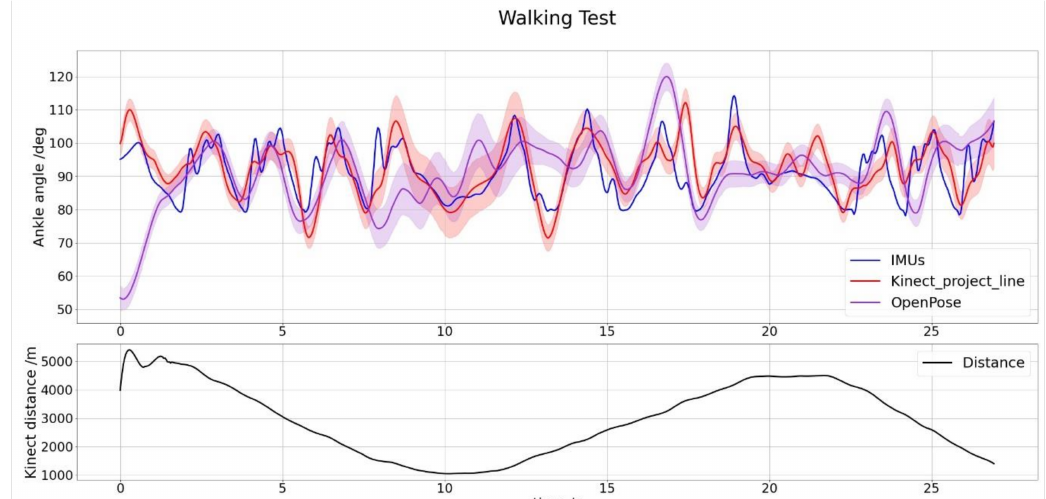
Figure 17. Graph showing the comparison between the ankle angle measured by the Kinect v2 with our projection lines method (red), the ankle angle measured by OpenPose (violet) and the angle measured by the IMUs using Euler’s angles (blue), for the walking test. Red and violet shaded area is the Kinect angle error following Equation (20). The body distance average is shown below to complete the information.